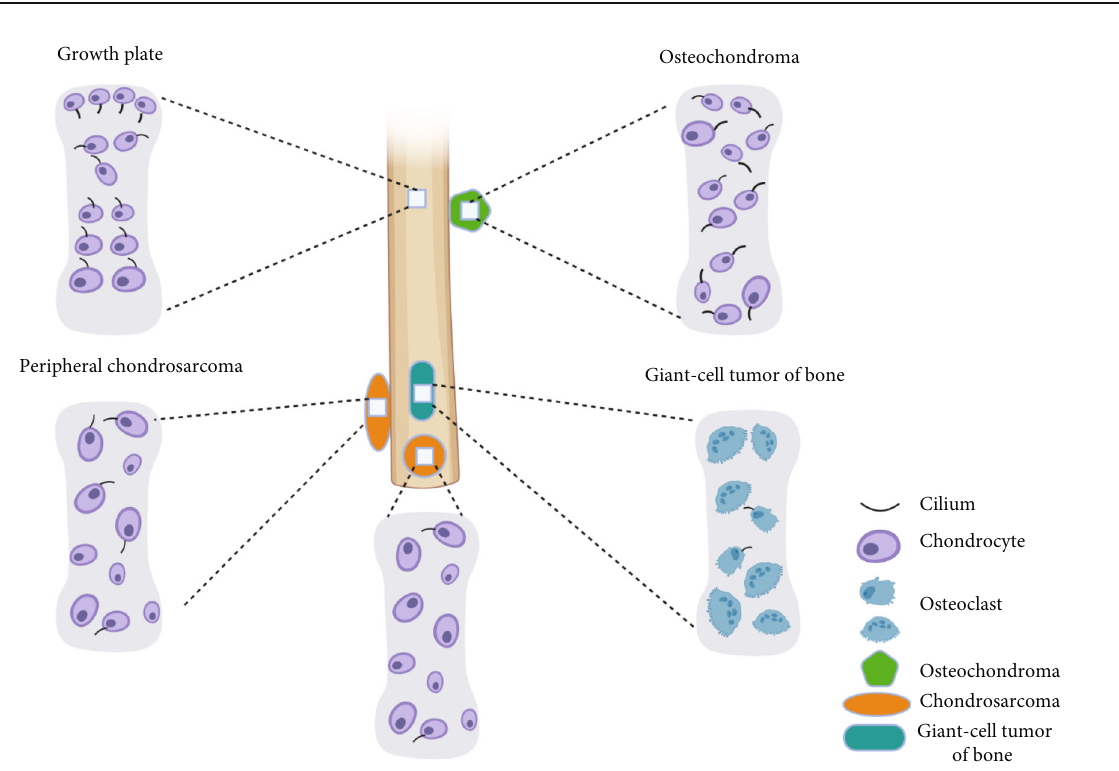
Figure 1: Schematic representation shows the cilium feature in bone or cartilage tumors. In both the proliferative and hypertrophic zones of the normal growth plate, the cilium is well orientated as shown in each layer. However, in osteochondroma, chondrocyte arrangement and cilia orientation are dramatically disorganized. In human malignant chondrosarcomas, cilium incidence is reduced and cilium orientation is disorganized. In the mouse peripheral chondrosarcoma, primary cilium is dramatically reduced and cilium orientation is disorganized. Giant cell tumor of bone is composed of mononuclear stromal cells and numerous macrophage giant cells, but only mononuclear stromal cells of giant cell tumor of bone present primary